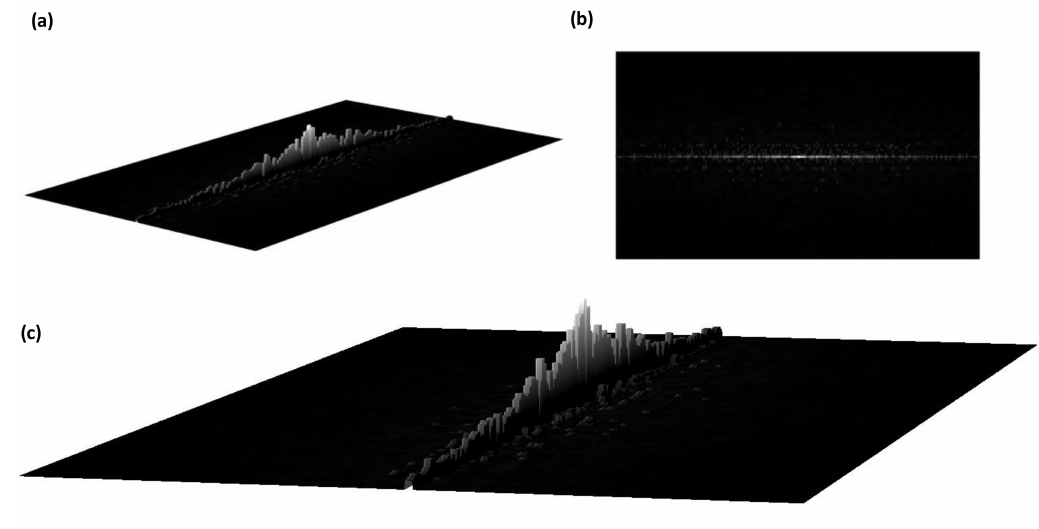
Figure 16. ( a – c ) DFT of the K-Means image: di ff erent perspectives of the 3D DFT processing of the homogeneous region.